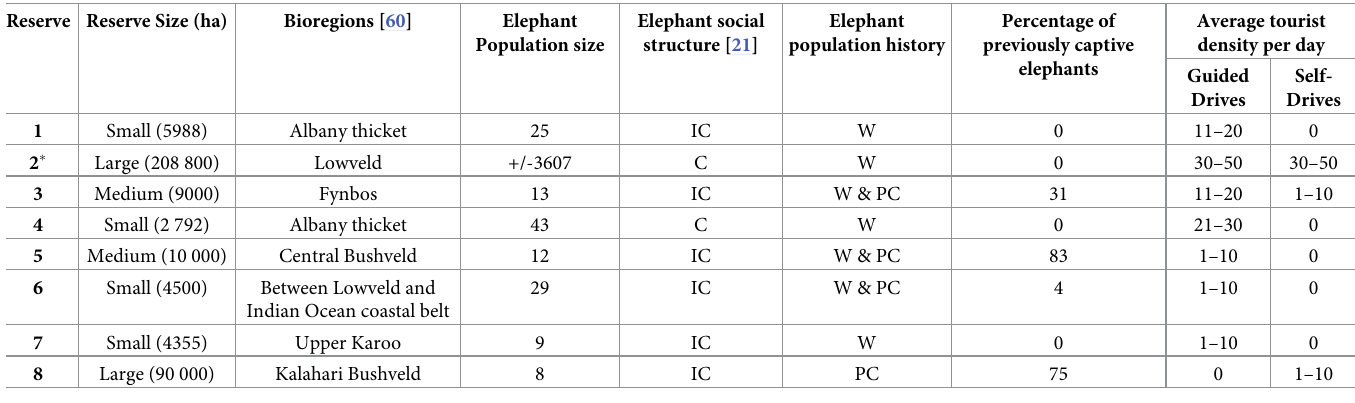
Table 2. Summary of the reserve size, bioregion, characteristics of the African elephant ( Loxodonta africana) population and the average daily tourist density (high- and low tourist season) of the eight reserves included in the study. Reserve Reserve Size